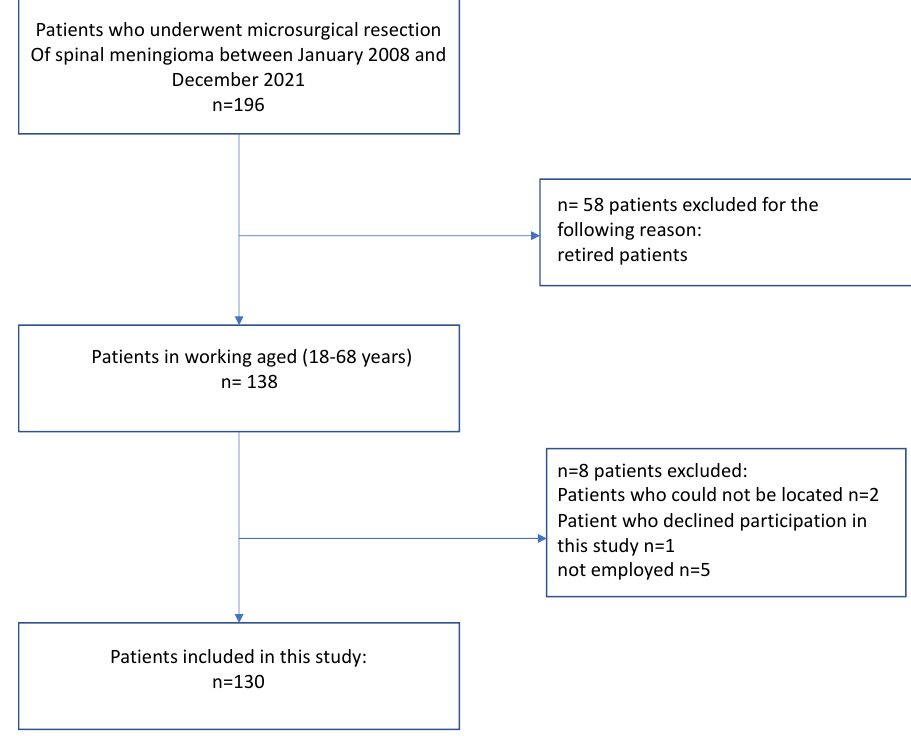
Figure 1. Flowchart describing the inclusion process of all patients who are actively employed at the time of surgery.